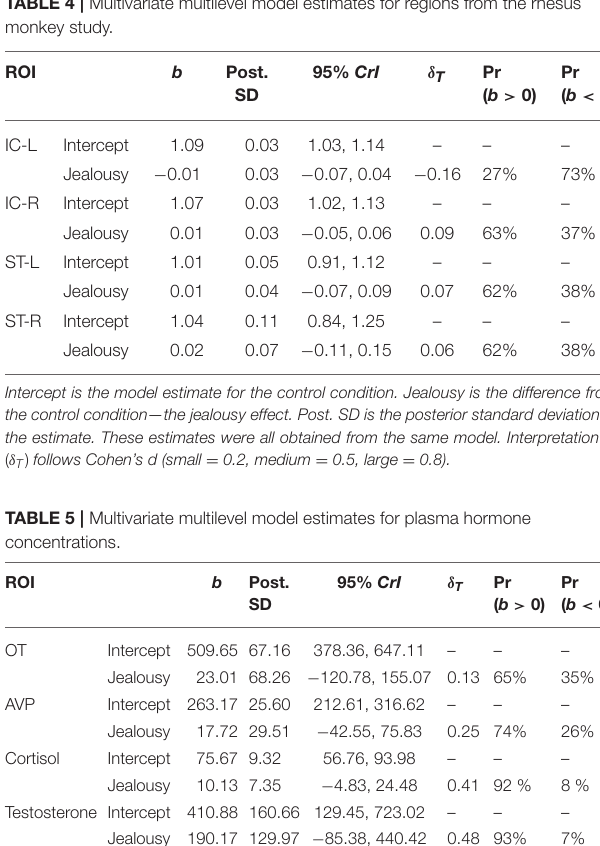
in total durations of behavior between the control and jealousy conditions (for ethogram see Table 1 ). Due to excessive zeroes, drinking and time off camera were not analyzed. There was some evidence for a positive effect (Pr( b > 0) = 90%) of jealousy condition on lip smacking duration ( b = 7.60, CrI = [ − 4.19–19.75], δ T = 0.55). The residual variance explained by subject ranged from 14%